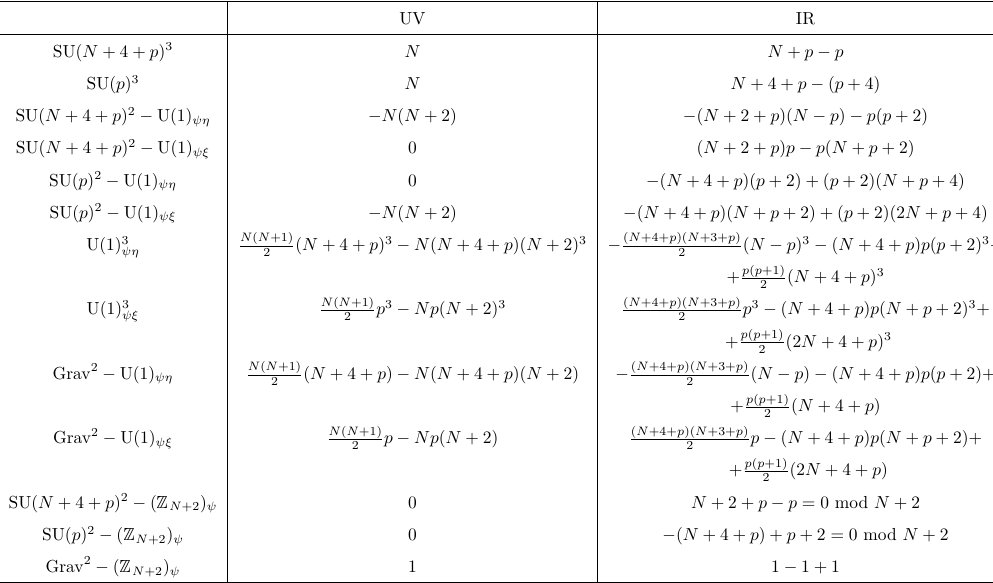
Table 7 . Anomaly matching checks for the IR chiral symmetric phase of the BY model. For N odd, the last three equalities are consequences of other